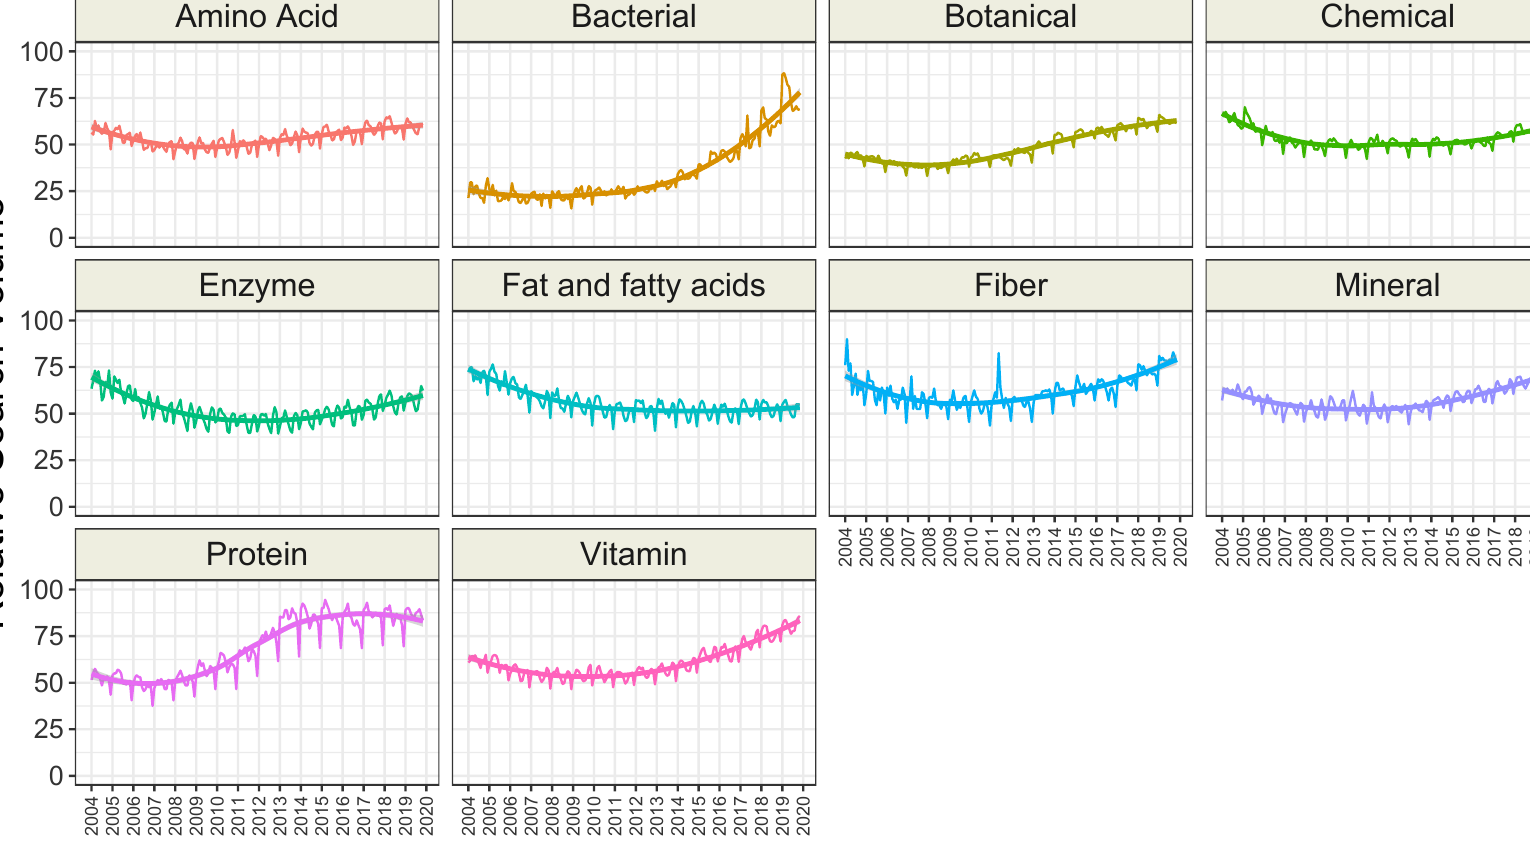
Figure 3. Time trends of relative search volumes of categories of dietary supplement-related